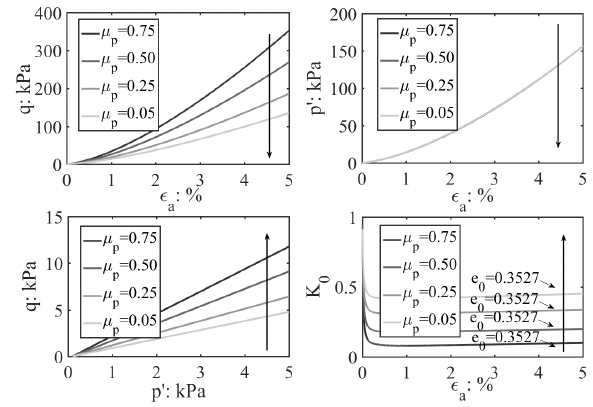
Figure 1. Dependency of macro-scale responses on interparticle friction for the FCC samples that were compressed from p (cid:48) 100 kPa .